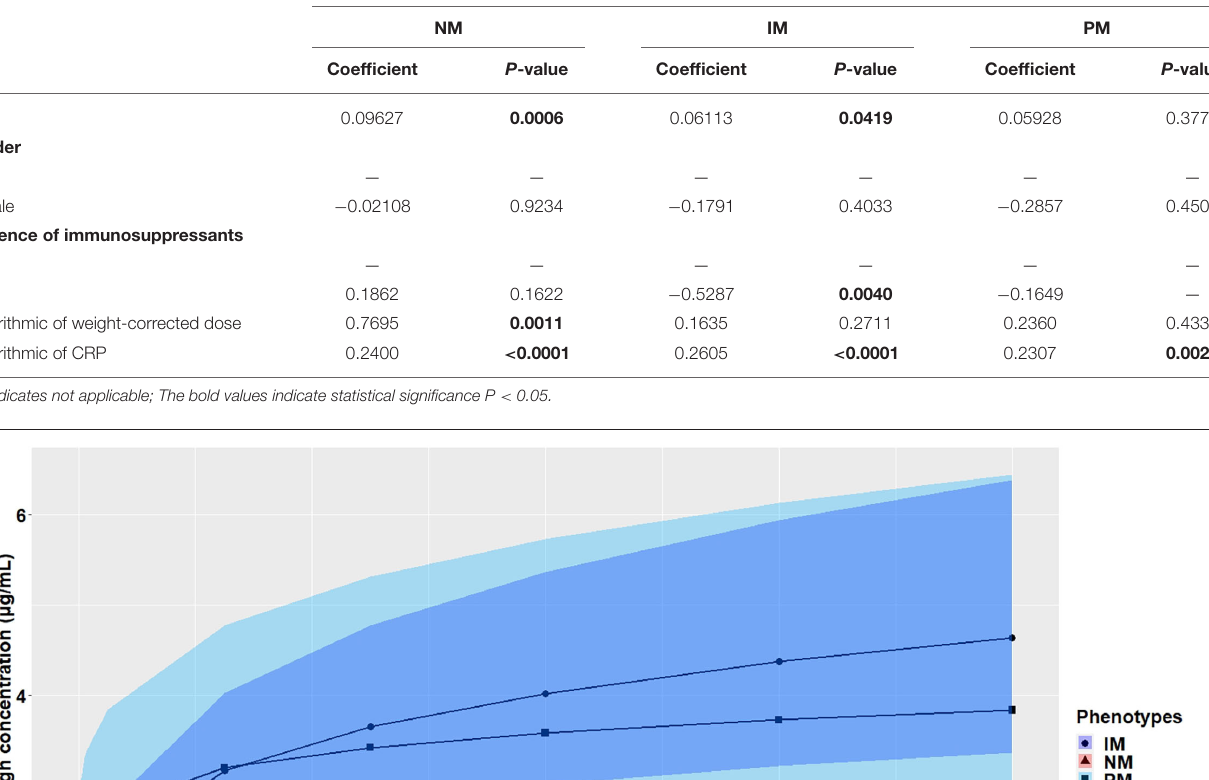
TABLE 4.1 | Effects of CRP concentration on voriconazole CDR ( µ g/ml per mg/kg) on three subgroups of patients based on phenotypes. Factor